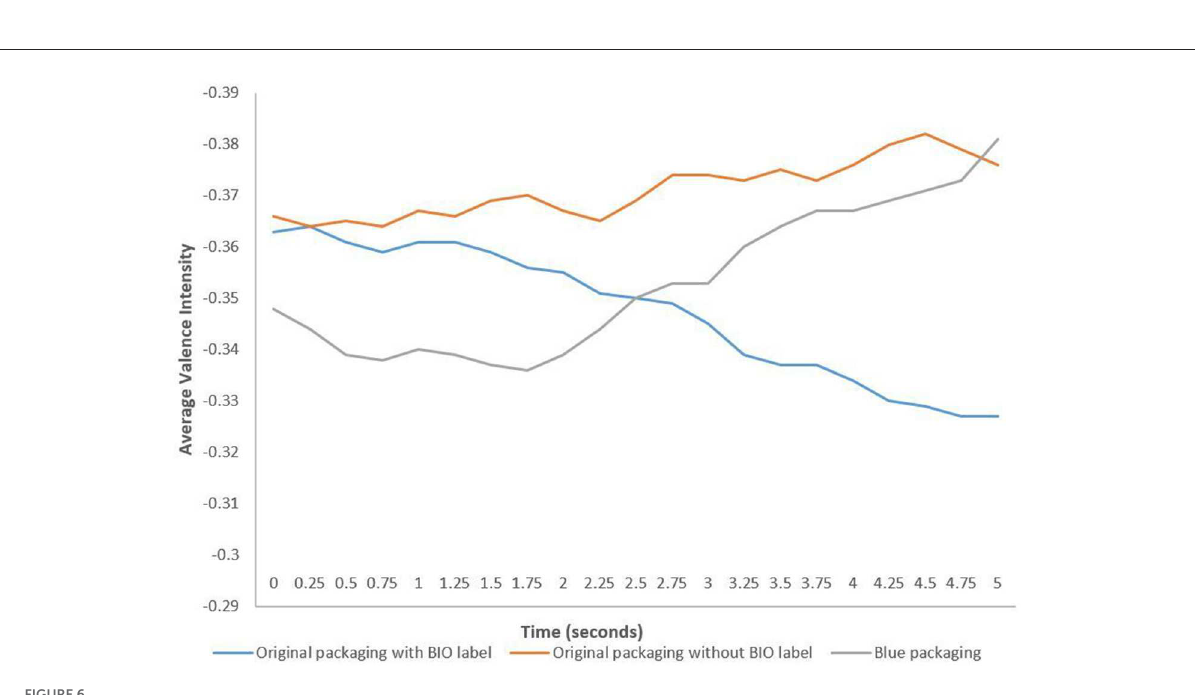
FIGURE6 Average emotional valence intensity when looking at